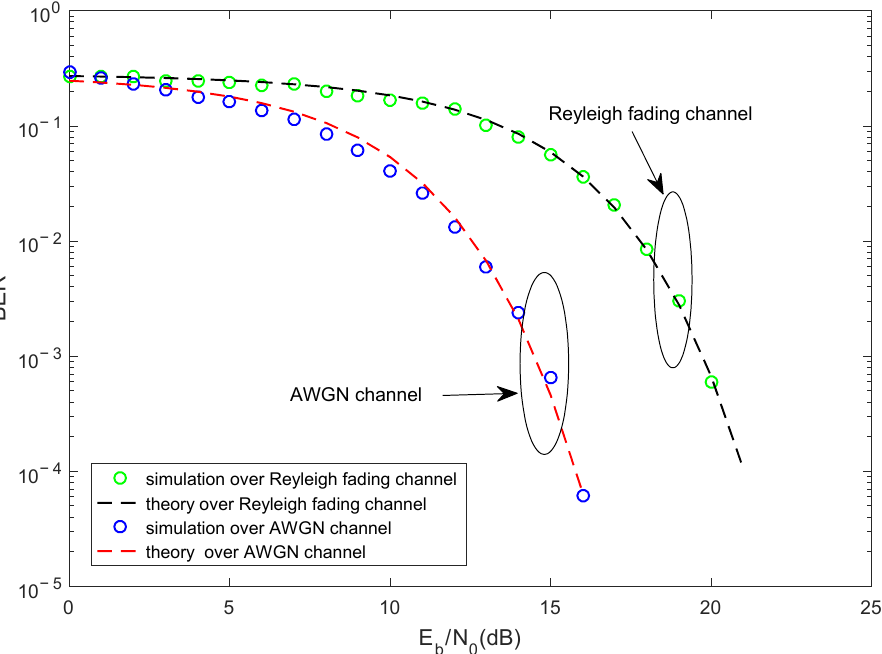
Figure 5. Comparisons of the simulation results and the theoretical results over the AWGN and Rayleigh fading channels with M = 16.